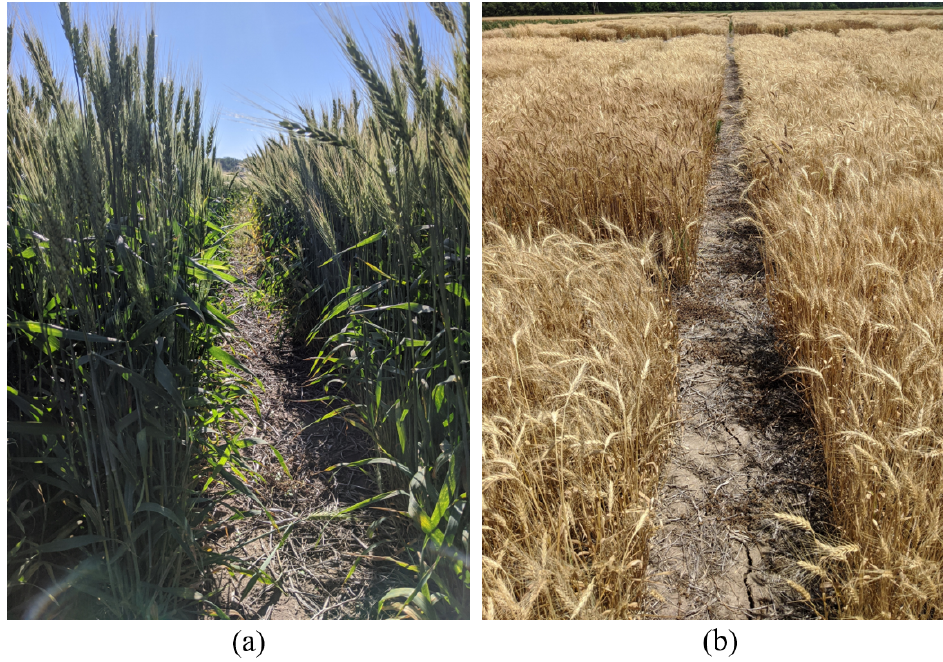
Figure 3. The visual overview of wheat at different states. ( a ) A sample image from the KSU Agronomy Farm when wheat is in reproductive state. ( b ) A sample image from the KSU Agronomy Farm when wheat is in mature state.